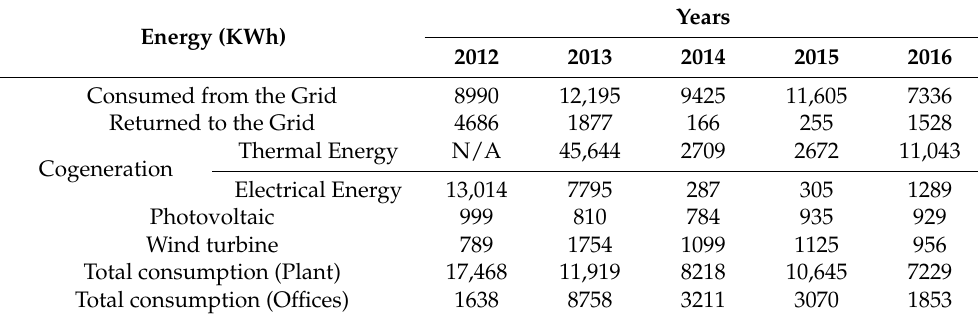
Figure 9. Physical model of ( a ) wind turbine, ( b ) energy storage system, ( c ) cogenerator control system, ( d ) cogenerator with the induction machine, ( e ) microgrid controllers. Table 1. Total energy balance analysis.